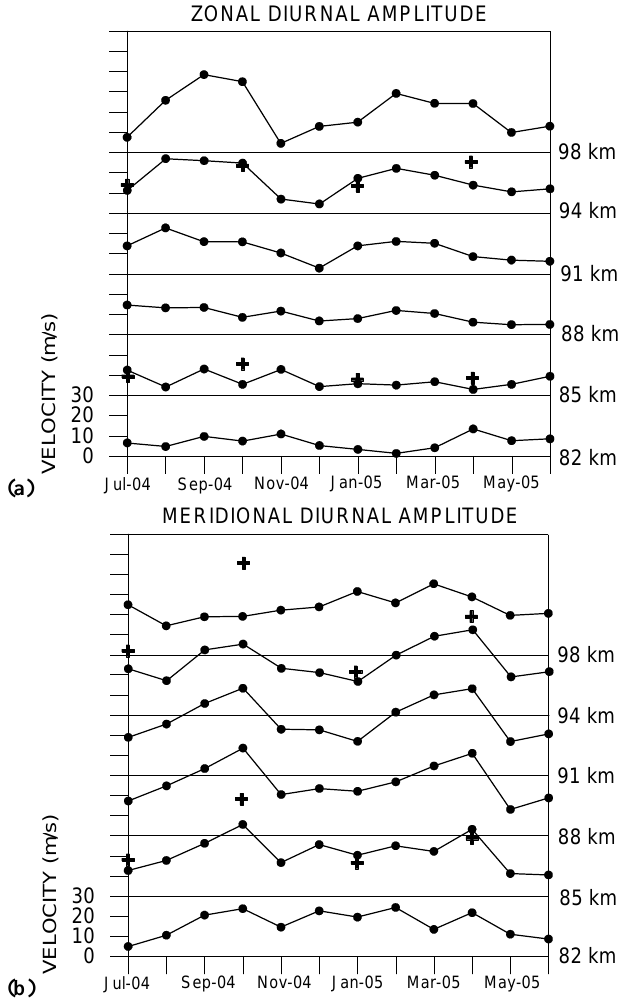
Fig. 4. Zonal (a) and Meridional (b) amplitude of the diurnal tide. Each horizontal line represents the value 0 (zero) at respective height. The symbol ( + ) represents the amplitude provided by the model GSWM02 at ~86 and ~94km.